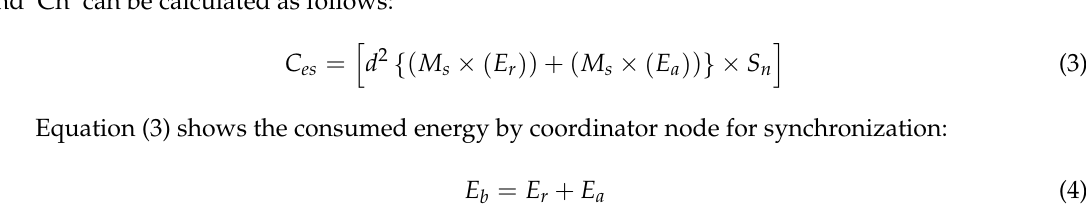
Table 2. Notations used and their description.